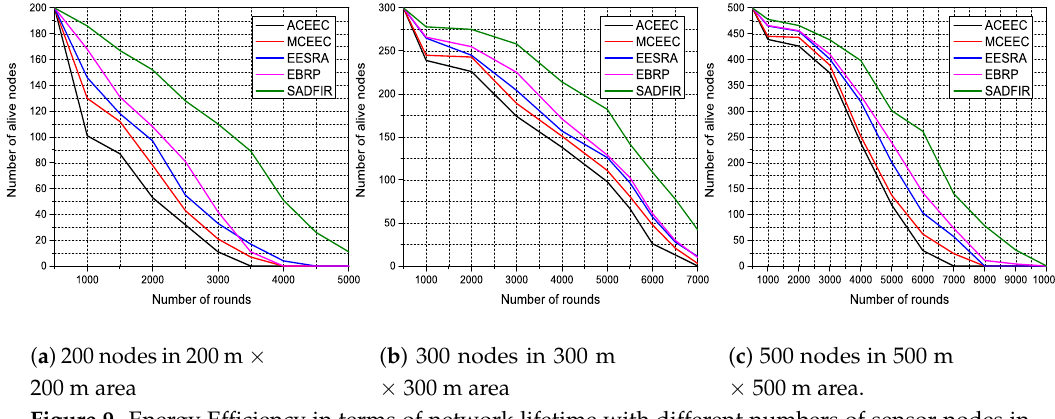
Figure 9. Energy Efficiency in terms of network lifetime with different numbers of sensor nodes in larger scales of network area.